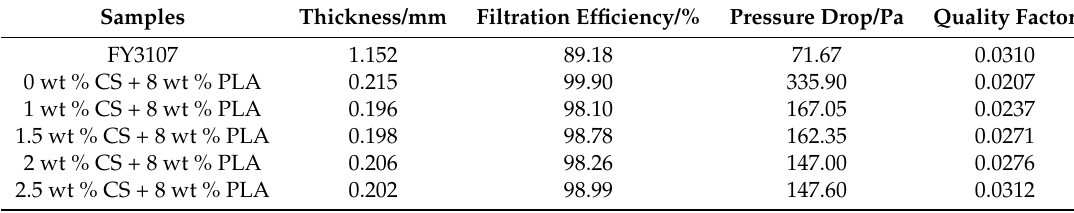
Table 5. Filtration performance of fibrous membranes fabricated with different mass ratios.